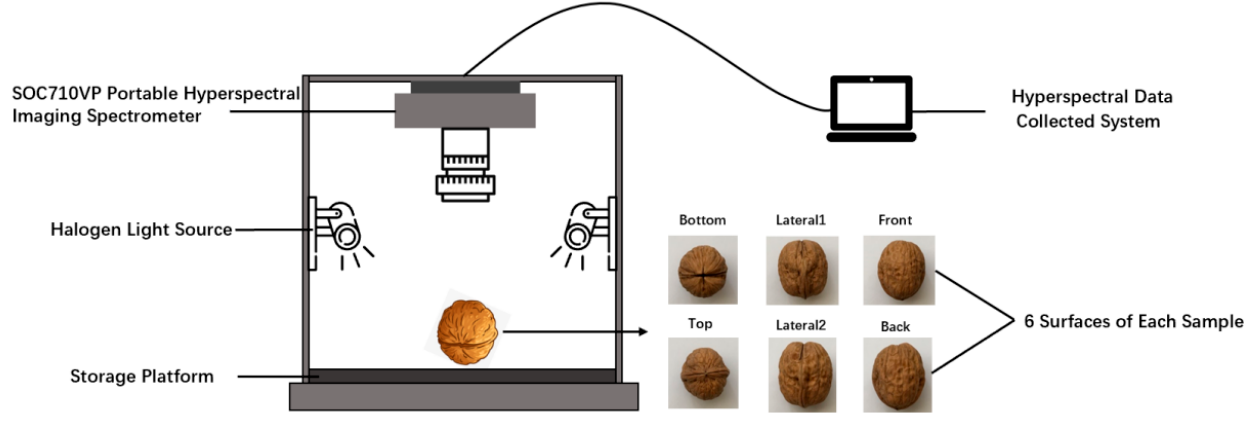
Figure 6. Hyperspectral data acquisition device.